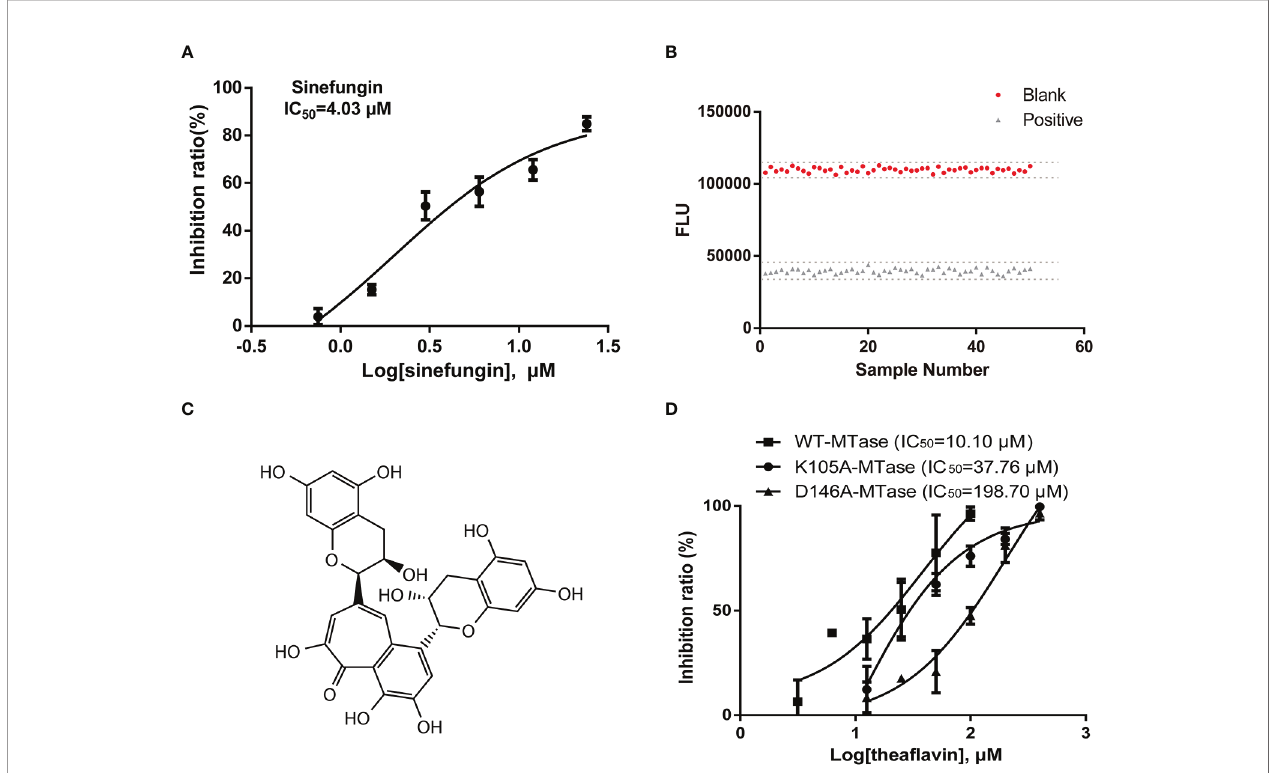
FIGURE 2 | Screening assays for ZIKV NS5 MTase inhibitors and identi fi cation of the hit compound thea fl avin. (A) Inhibition of MTase by the positive control sinefungin. Two-fold dilutions (0.75-24 m M) of sinefungin were used. The MTase activity of the DMSO control was set as 100%. (B) Z ’ factor of the luminescence- based assay. MTase was incubated with 20 m M positive control sinefungin or 1% DMSO for 1 h at room temperature. Then the luminescence intensity was measured and Z ’ factor was calculated as described. (C) Structure of thea fl avin. (D) WT-MTase and mutant MTases inhibition assays. Half maximal inhibition concentration (IC 50 ) values were calculated from dose-response curves in three independent experiments using GraphPad